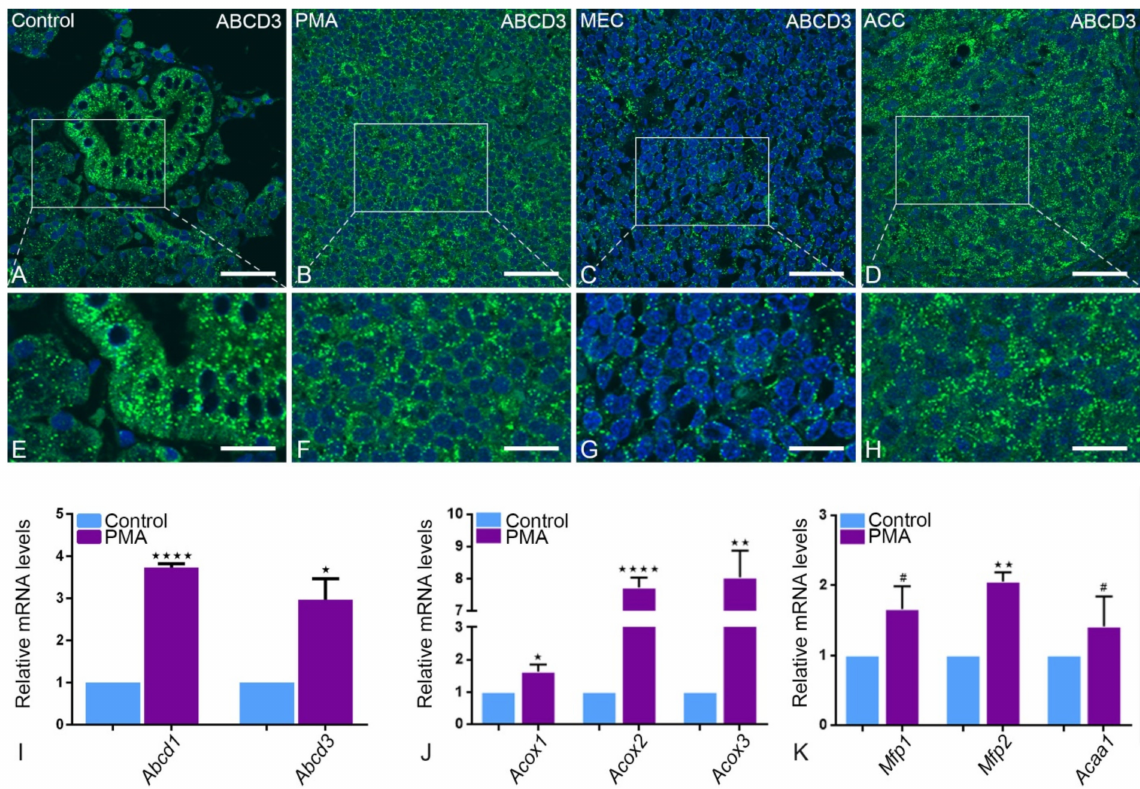
Figure 4. Peroxisomal proteins and mRNAs involved in lipid transport and β -oxidation pathways: ABCD3 is more highly expressed in striated duct cells ( E ) than in acinar cells ( A ). In comparison, the marker reacts low in MEC ( C , G ). PMA ( B , F ) and ACC ( D , H ) show an even higher expression in IF than the control group. This is validated by the higher mRNA expression of Abcd1 (**** p < 0.0001) and Abcd3 (* p = 0.0164) in ( I ). In addition, Acox1 (* p = 0.0404), Acox2 (**** p < 0.0001) and Acox3 (** p 0.0010) ( J ), Mfp1, Mfp2 (** p = 0.0012) ( K ) and Acaa1 show a high abundance in PMA mRNA levels. Bars represent 50 µ m: ( A – D ); 18 µ m: ( E – H ). (Explanation of the notations: The number of asterices signifies the degree of significance of the p -value, while # means not